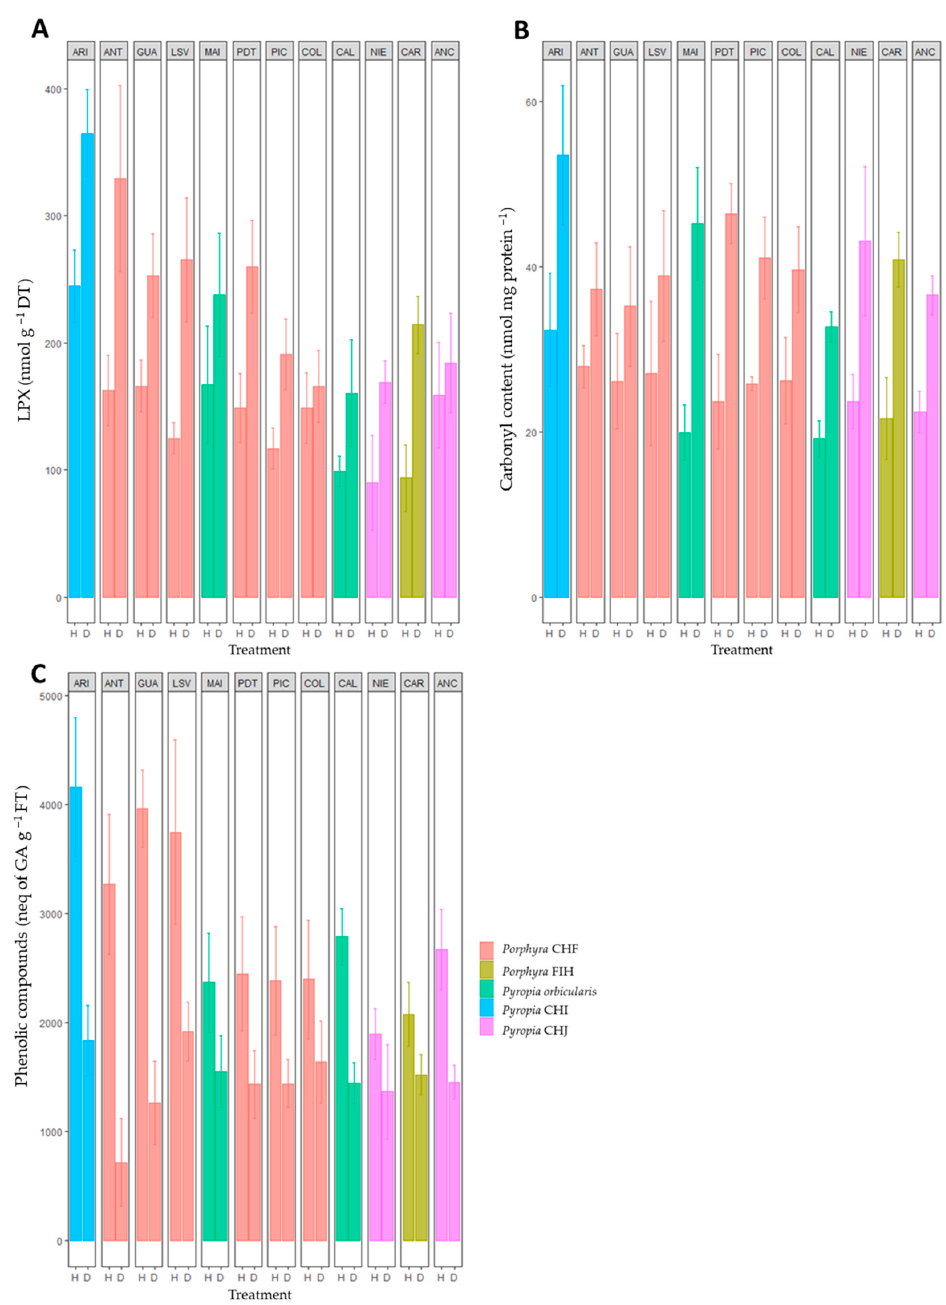
Figure 4. ( A ) Lipid peroxidation, ( B ) protein oxidation, and ( C ) phenolic compound